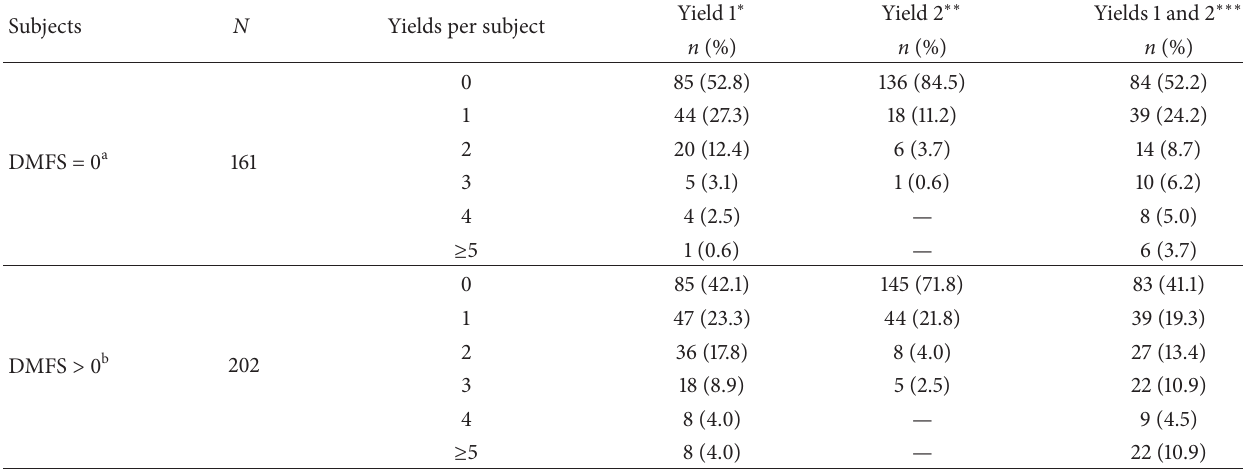
Table 4: The distribution of subjects according to the sum of yield surfaces in relation to the clinical findings.